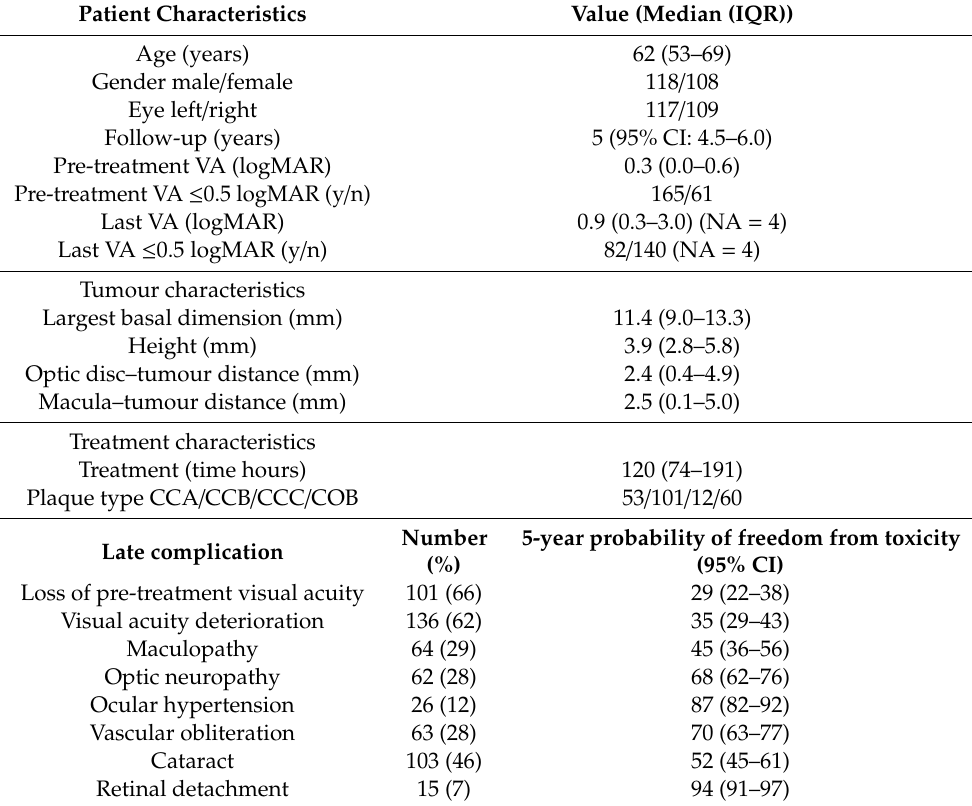
Table 2. Descriptive statistics of study participants (n = 226): Patient, tumour, and treatment characteristics, and list of late complications with raw incidence and five-year probability (based on Kaplan–Meier estimates) including 95% confidence interval (CI). logMAR: the logarithm of minimum angle of resolution. VA: Visual acuity. Median (IQR: interquartile